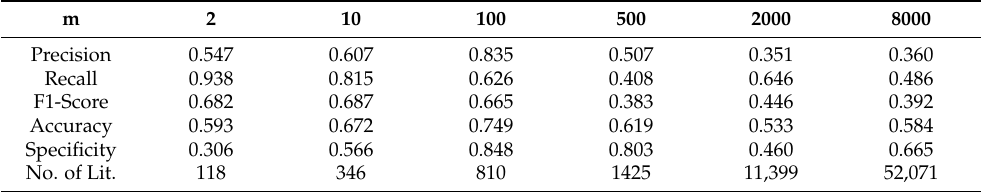
Table 20. Performance of TM with Booleanized continuous features on Heart Disease dataset.